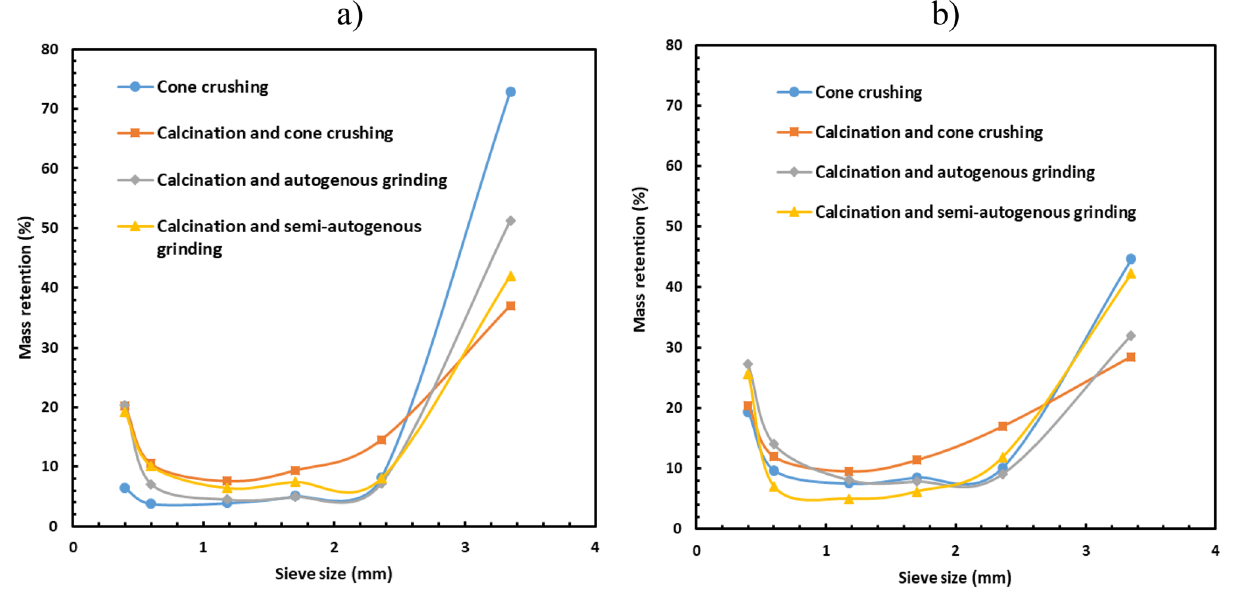
Figure 2. Retention of ( a ) TDMS, ( b ) PF on different sieves.